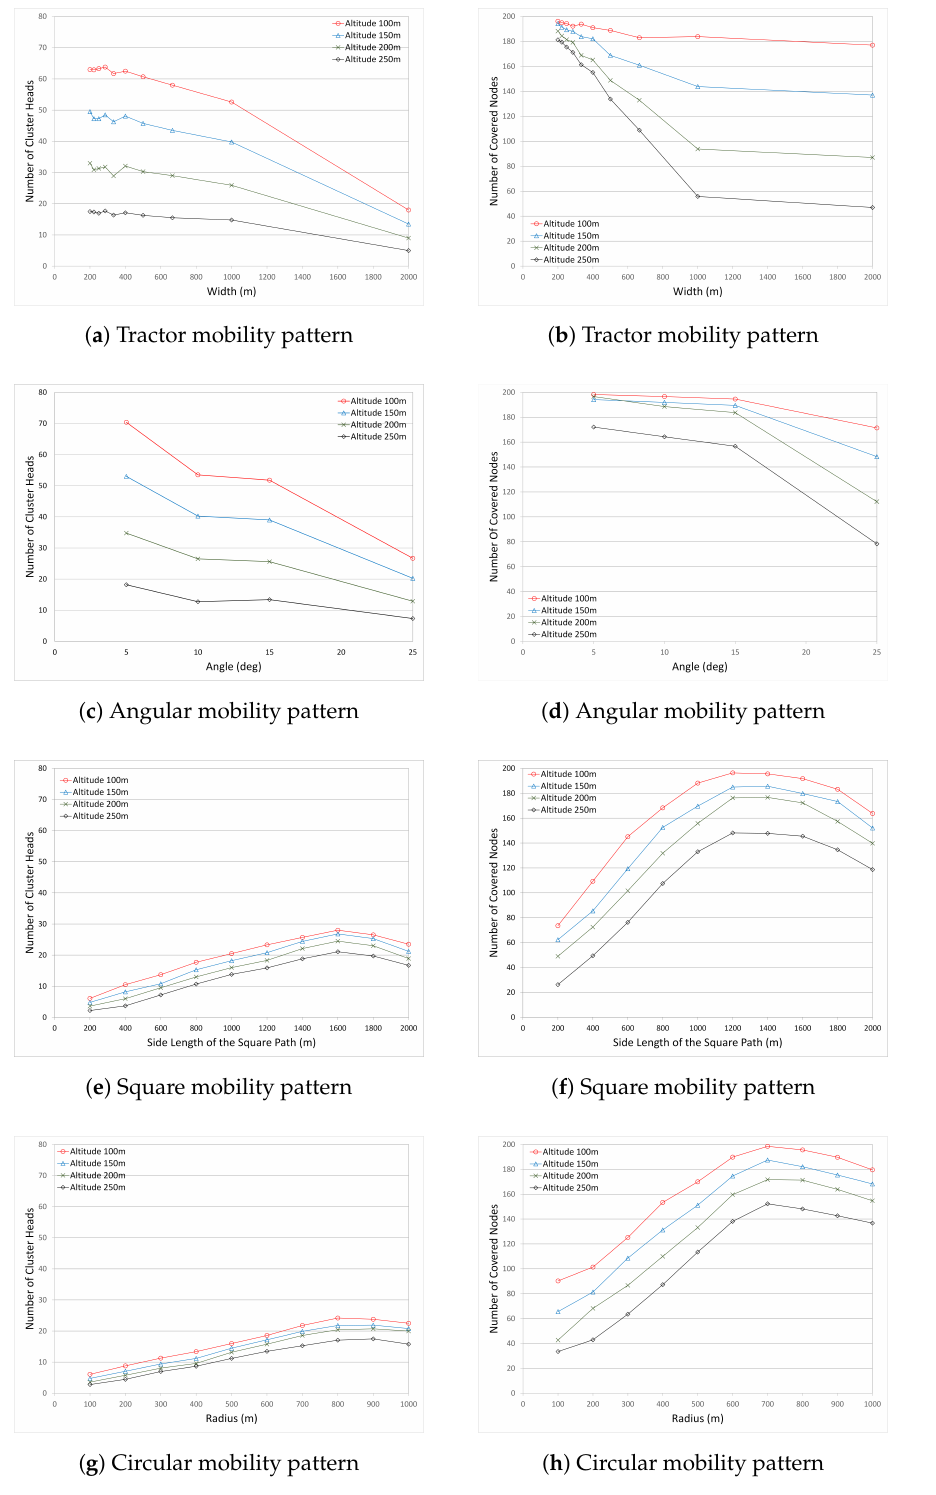
Figure 4. Comparison of the number of cluster heads (CHs) and the number of covered nodes for all mobility